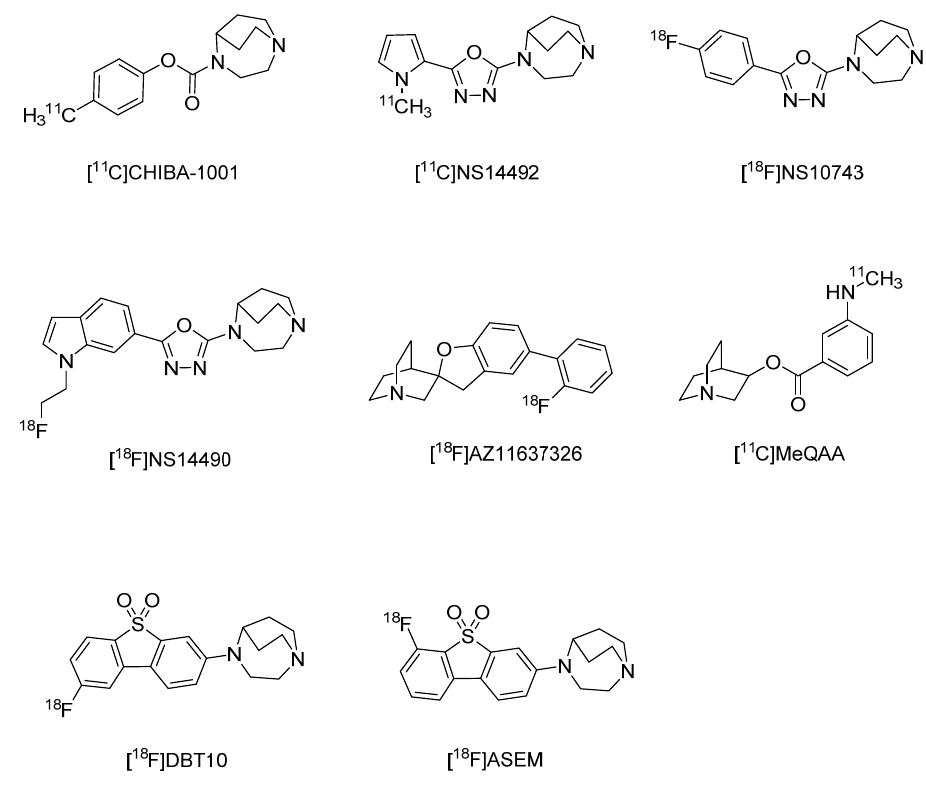
Figure 3. Representative α 7 nAChR radioligands for PET.